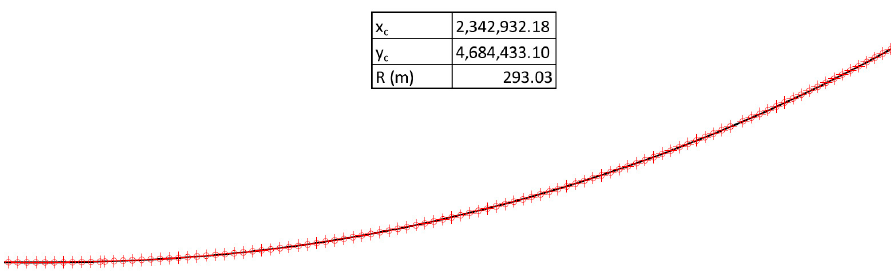
Figure 11. Least square circle fitting for the center and radius coordinates definition.